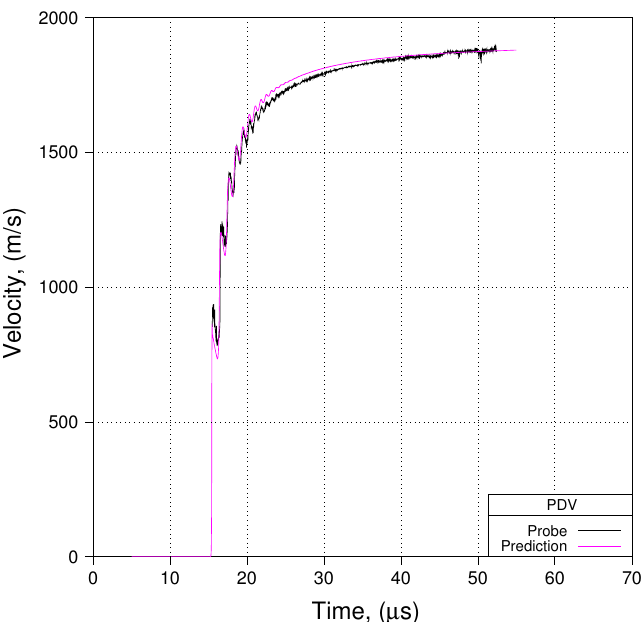
Figure 15. Prediction to Data: Shot 01, Probe 02, R165.